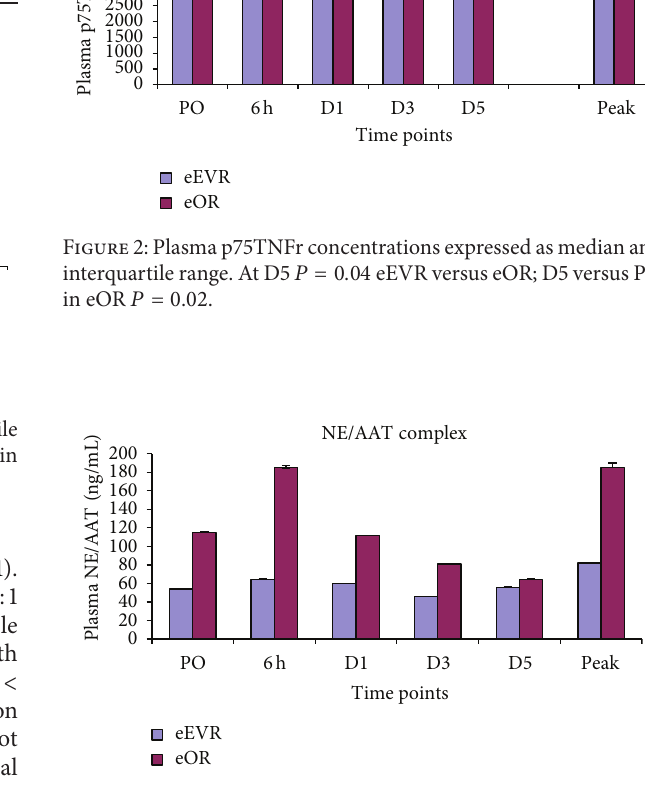
Figure 3: Plasma NE/AAT concentrations expressed as median and interquartile range. At PO, 6h, D1 and peak 𝑃 < 0.05